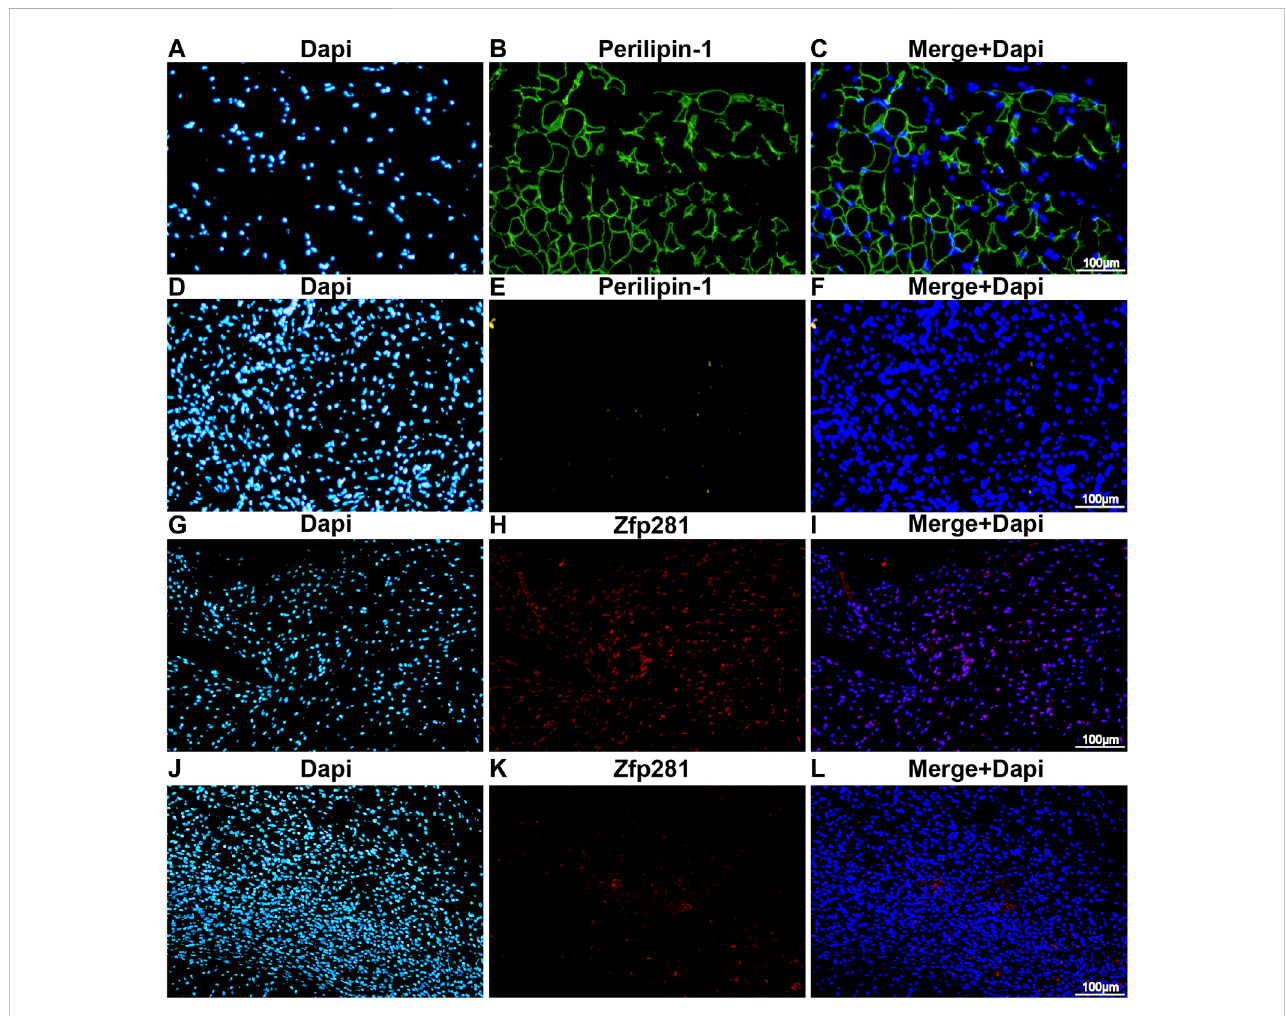
FIGURE 1 Zfp281 is upregulated at an early stage in adipose de novo regeneration tissues. (A – F) Immuno fl uorescence staining of perilipin-1 in bFGF-loaded DAM (A – C) and DAM-injected mouse tissuees (D – F) at 12 weeks; (G – L) immuno fl uorescence staining of zfp281 in bFGF-loaded DAM (G – I) and DAM-injected mouse tissues (J – L) at 1 week. Perilippin-1 is labeled in green. Zfp281 is Labeled in red. Nuclei are labeled with DAPI in